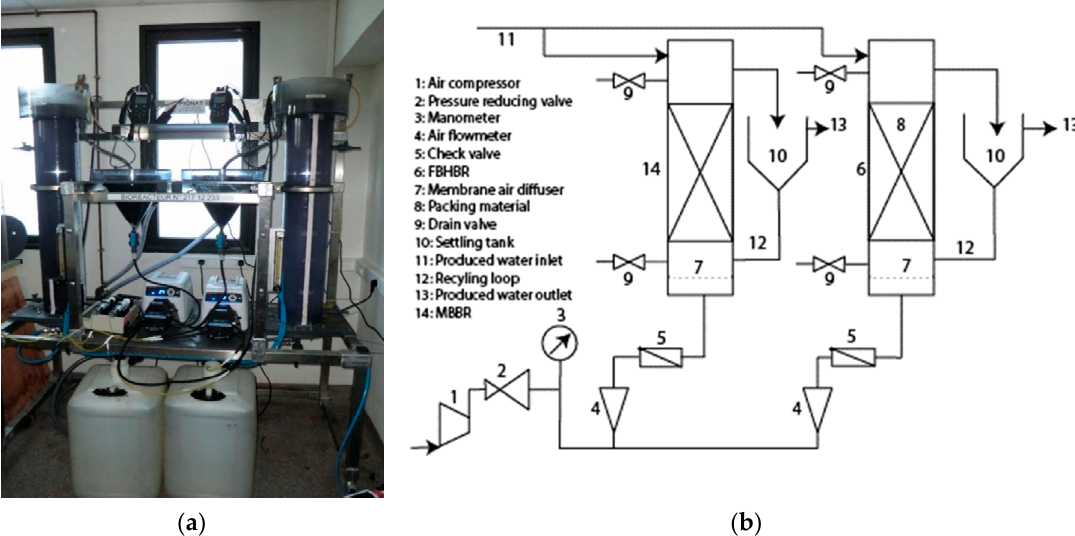
Figure 1. Laboratory pilots’ plants (MBBR and FBHBR): ( a ) photograph and ( b ) schematic diagram of the experiemental setup.